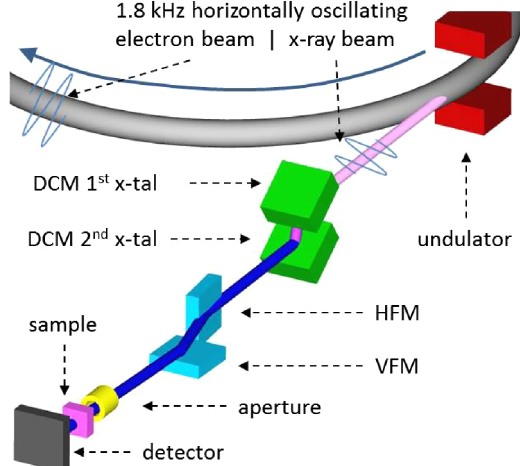
FIG. 1. Schematic of the electron storage ring, undulator source, and beamline optics. Radio frequency (rf) accelerator cavities (not shown) replenish energy lost to x-rays generated by the bending magnet or undulator sources. The 1.8 kHz power line harmonic leaks through the high voltage rf power supplies driving a 1 μ m amplitude horizontal oscillation in the particle beam. A narrow energy band of x-rays generated in the undulator are selected by the dual crystal monochromator (DCM). The horizontal focusing mirror (HFM) and vertical focusing mirror VFM steer and focus the beam at the sample. The collimating aperture reduces the beam size before passing through the sample. The intensity detector in this demonstration is a silicon PIN junction